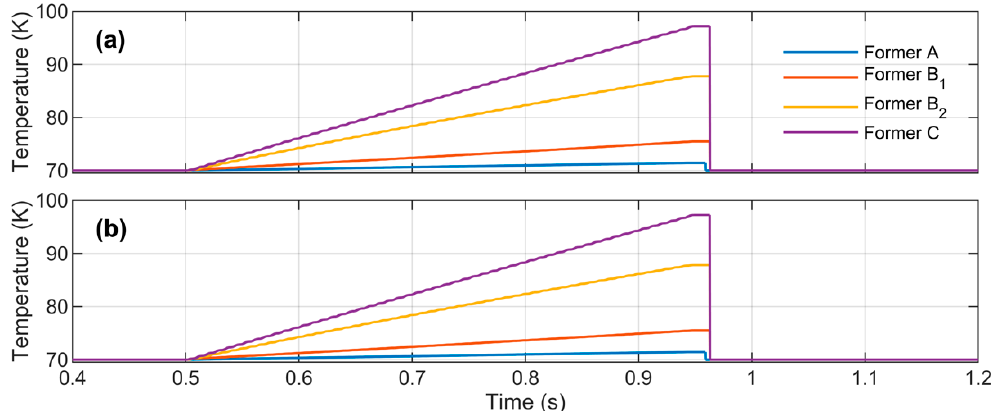
Figure 29. HTS cable temperatures in case DCR and DOCR fail: ( a ) HTS 1 ; ( b ) HTS 2 .